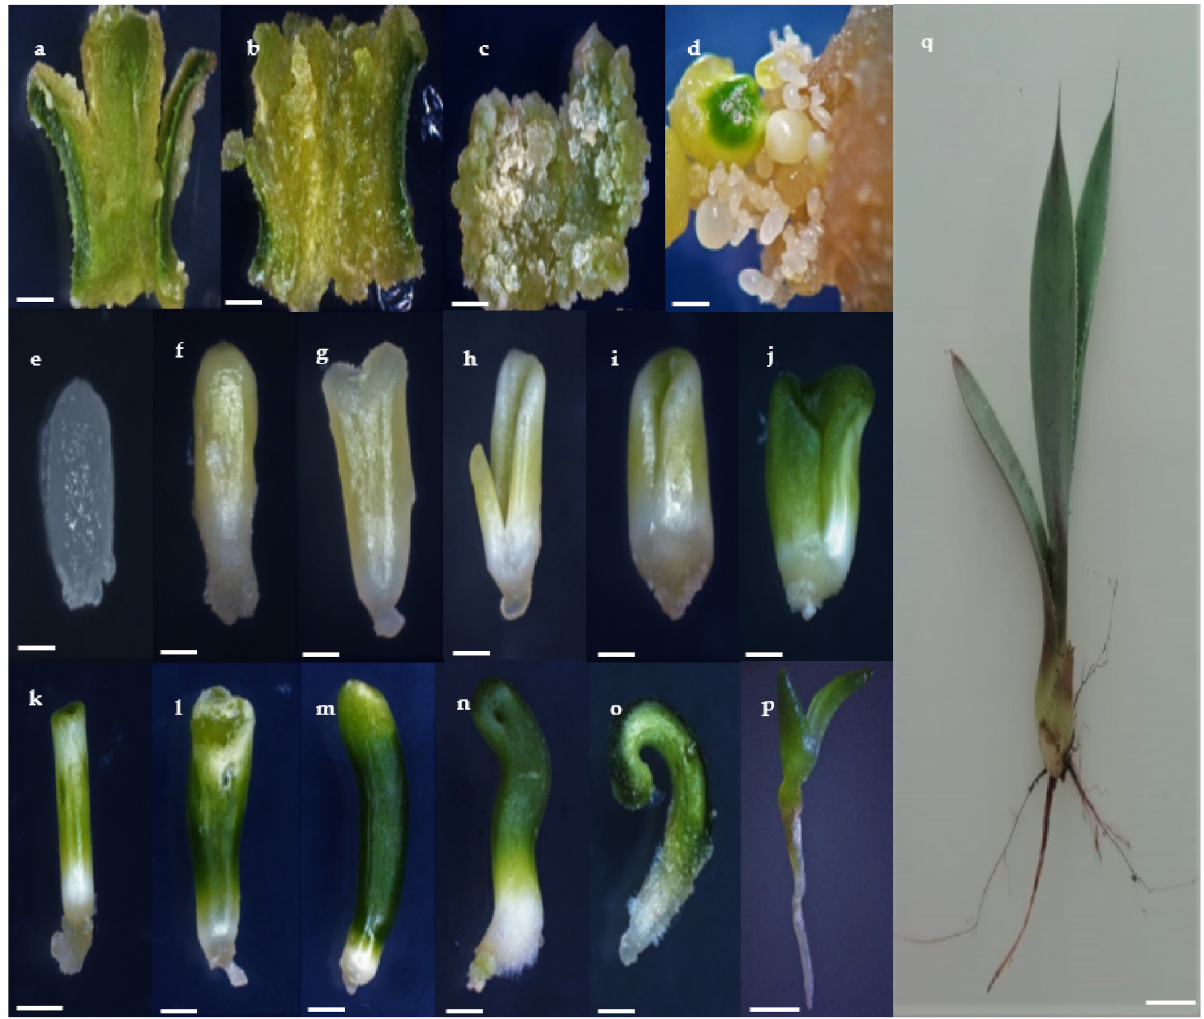
Figure 1. Stages of indirect somatic embryogenesis in Agave tequilana Weber cultivar ‘Chato’. Callus production in leaf after ( a ) 10 days, ( b ) 25 days, and ( c ) 40 days of culturing (bars 2.0 mm), ( d ), embryogenic callus in expression medium with somatic embryos (SEs) at several stages after 60 days of culturing (bar 2.0 mm), ( e ) and, ( f ), globular SEs without and with chlorophyll presence (bars 0.2 mm and 0.5 mm), respectively, ( g ) and ( h ) scutellar stage (bars 0.5 and 1.0 mm), respectively, ( i – o ), subsequent development of the colleoptilar stage presenting radicle origin. ( i , j ) (bars 1.0 mm and ( k – o ) bars 2.0 mm), respectively, ( p ) Somatic embryo elongation and tissue maturation (bar 5.0 mm), and ( q ) ex vitro-grown plant under greenhouse conditions (250 d) (bar 1.0